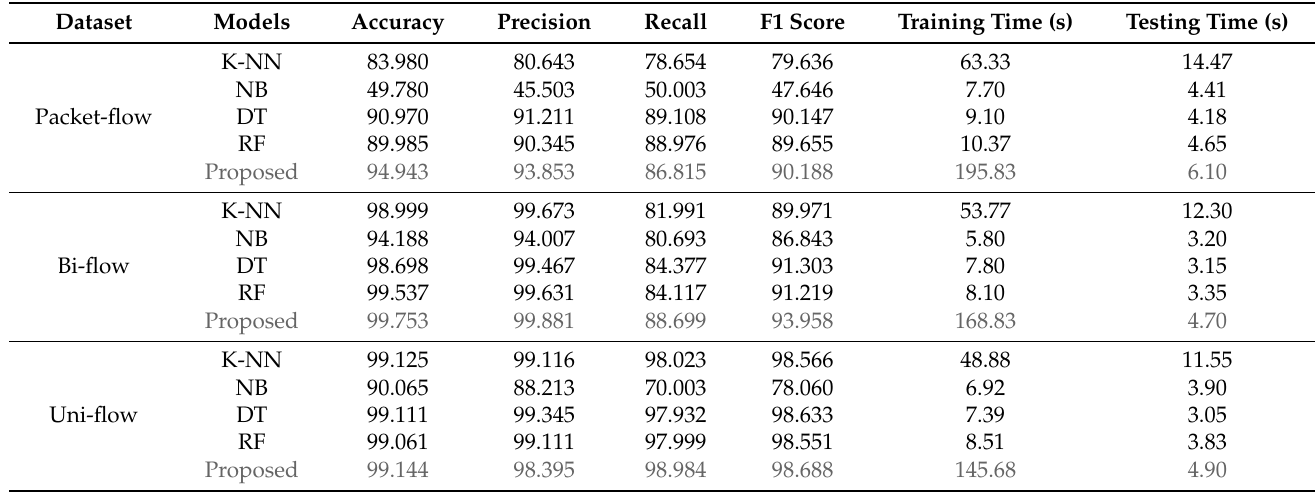
Table 17. Performance comparison of the proposed DL-based IDS with other ML algorithm-based IDSs (binary-class classification). Dataset